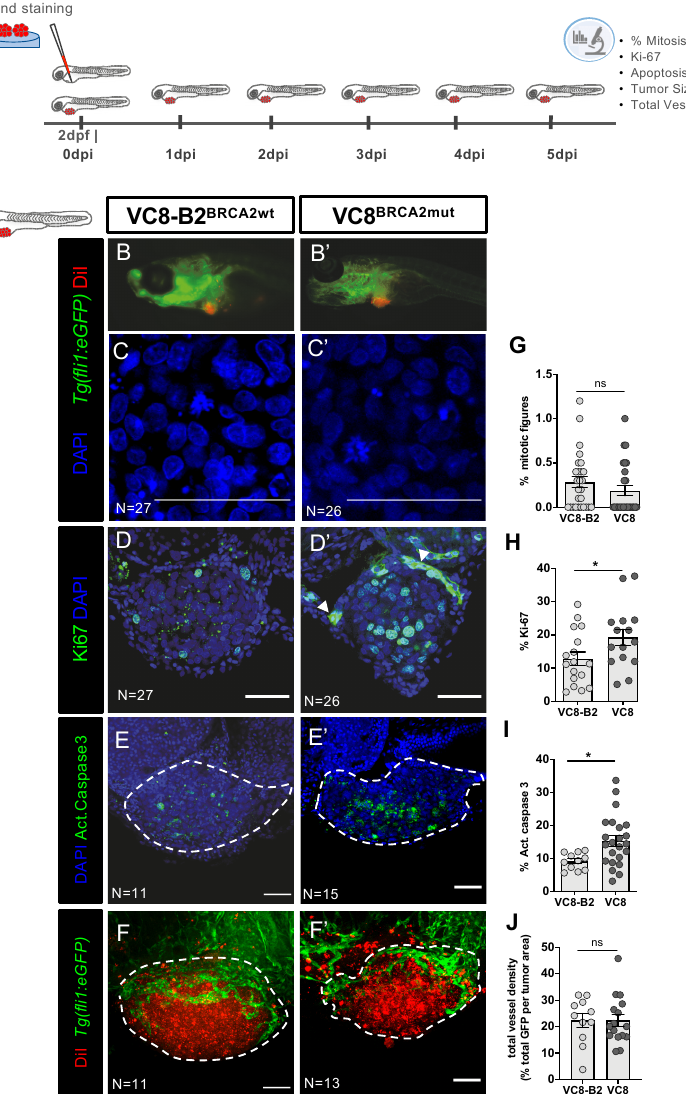
Figure 1. BRCA status can influence cancer-related hallmark phenotypes in a zebrafish xenograft model. VC8-B2 BRCA2wt and VC8 BRCA2mut hamster cell lines were fluorescently labeled with Vybrant CM-DiI (in red) and injected in the perivitelline space (PVS) of 2 days post fertilization (2dpf) Tg(Fli1:eGFP) zebrafish embryos ( A ). At 5dpi, zebrafish xenografts were imaged in the stereoscope ( B,B’ ) and by confocal microscopy ( C – F’ ). The percentage of mitotic figures (nuclei in blue) ( G ), Ki-67 (in green) ( H ), activated caspase 3 (in green) ( I ) and total vessel density ( J , %GFP area—in green—relative to the whole tumor area) were quantified. All images are anterior to the left, posterior to right, dorsal up, and ventral down (as depicted in the scheme on top left). The dashed lines delineate the tumor area. Scale bar: 50 µ m. Results are from three independent experiments and expressed as mean ± SEM, each dot represents one xenograft. The total number of xenografts analyzed is indicated in the images. Statistical results: not significant (ns) > 0.05, * p ≤